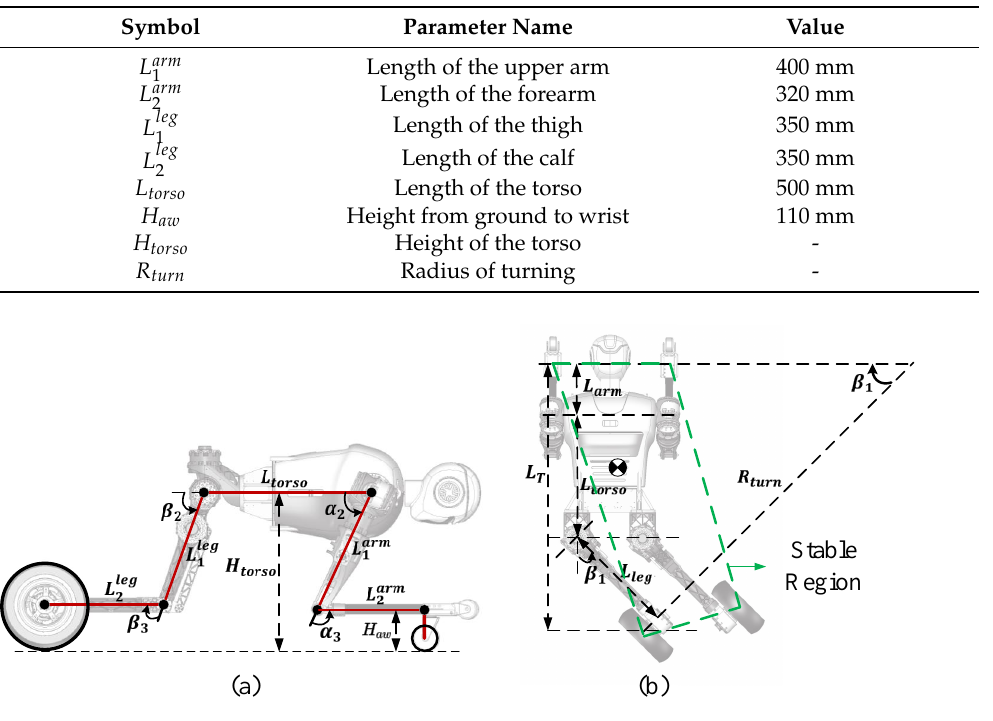
Figure 7. The model of limbs crawling motion: ( a ) The variable height crawling model; ( b ) The crawling turning